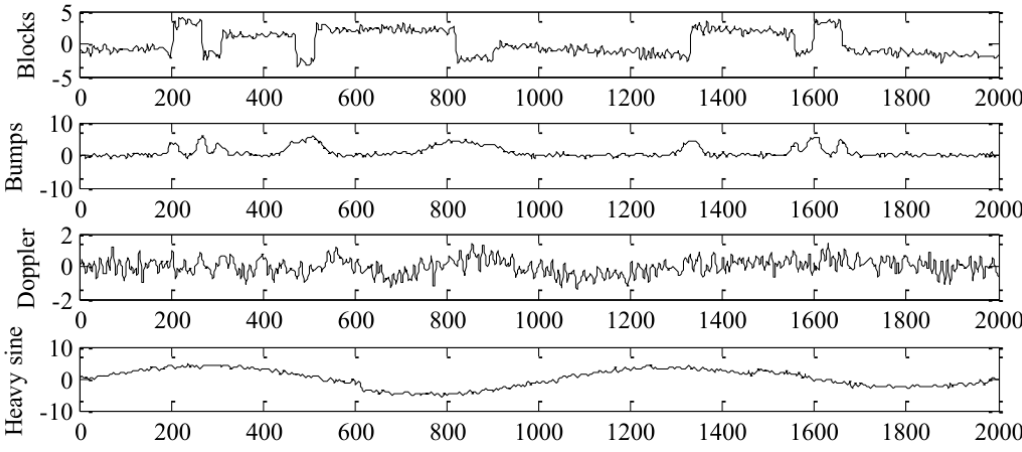
Figure 6. Results of wavelet-EMD denoising (the original signal SNR: 4dB). Table 1. Denoising results from the different methods .